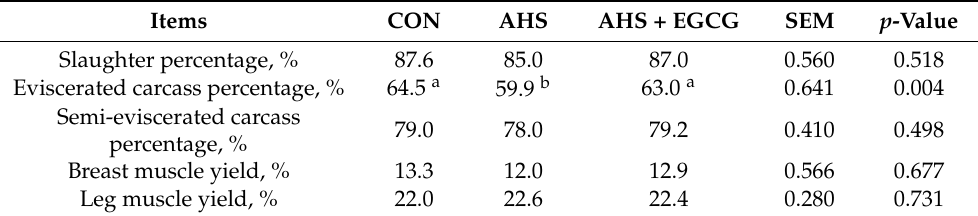
Table 3. Effect of EGCG on carcass traits of broilers subjected to acute heat stress.